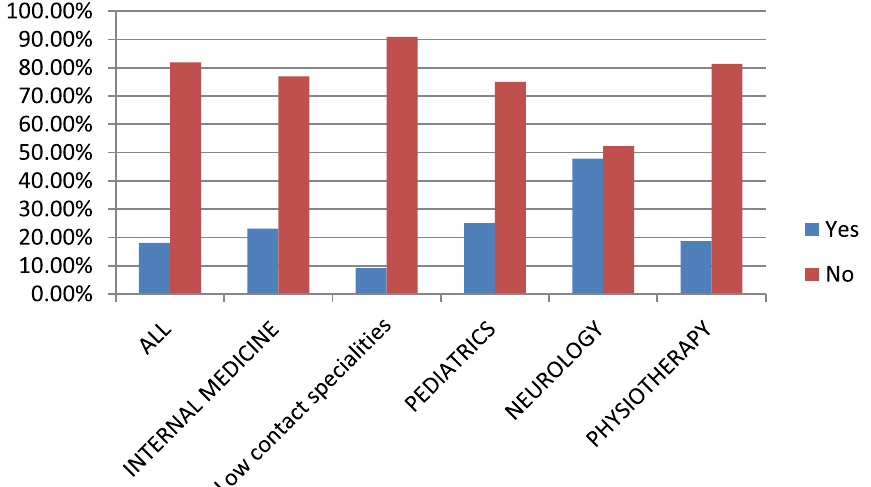
Fig. 3 Percentages and comparison among participants in different specialties regarding their responses about the presence of a swallowing clinic in their